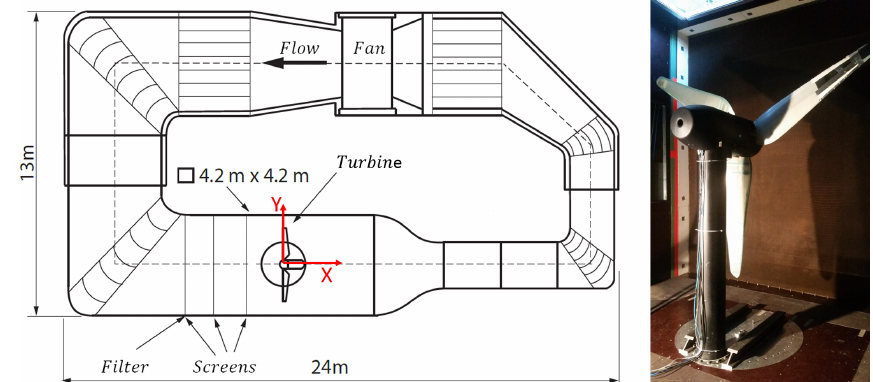
Figure 1. Outline of GroWiKa, modified from Klein et al. (2018) (left). Berlin Research Turbine – BeRT in the wind box (right).